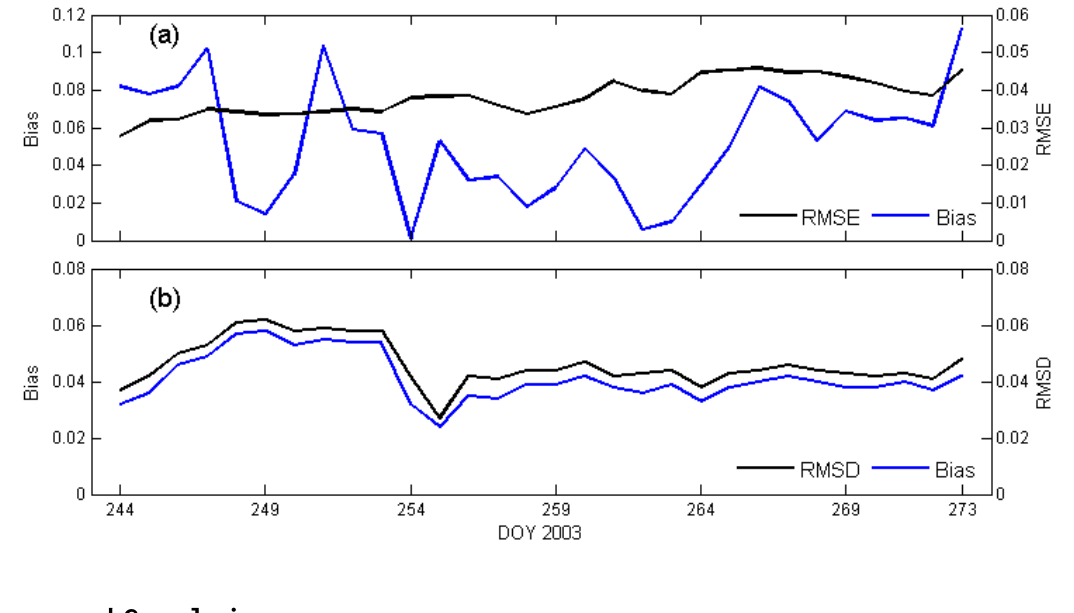
Figure 9. Kriging performance assessment (a) Bias and RMSE between kriged soil moisture map and ten Jackknifed site locations (b) Area average whole network, Root mean square difference (RMSD) and bias between kriged Mesonet and AGRMET soil moisture maps shows higher RMSD during dry